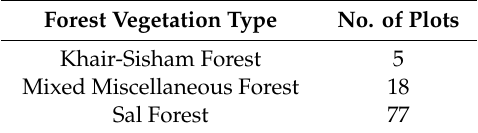
Table 1. Number of plots of the field-collected data for forest height measurement. Forest Vegetation Type No. of Plots